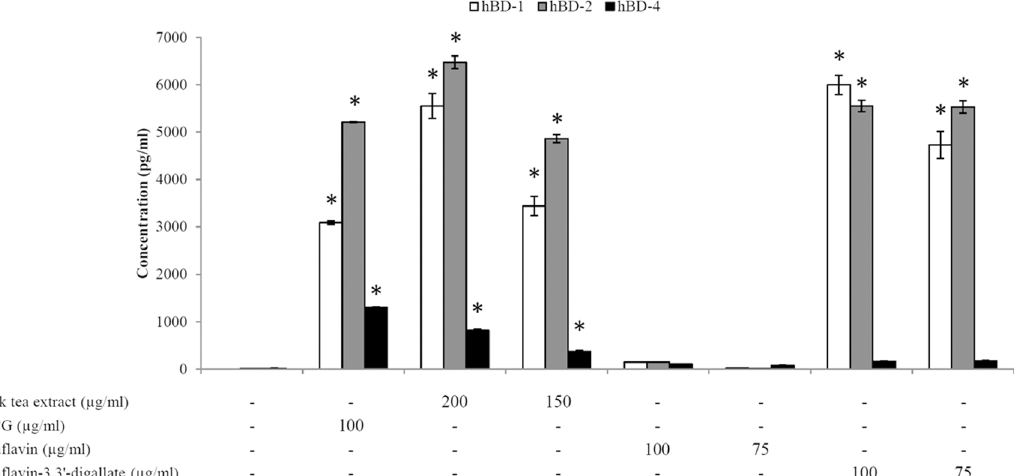
Fig 3. Effects of the black tea extract, theaflavin, theaflavin-3,3 ’ -digallate, and EGCG on the secretion of hBDs by oral epithelial cells. * , significantly different from control (no compounds) at p < 0.01.